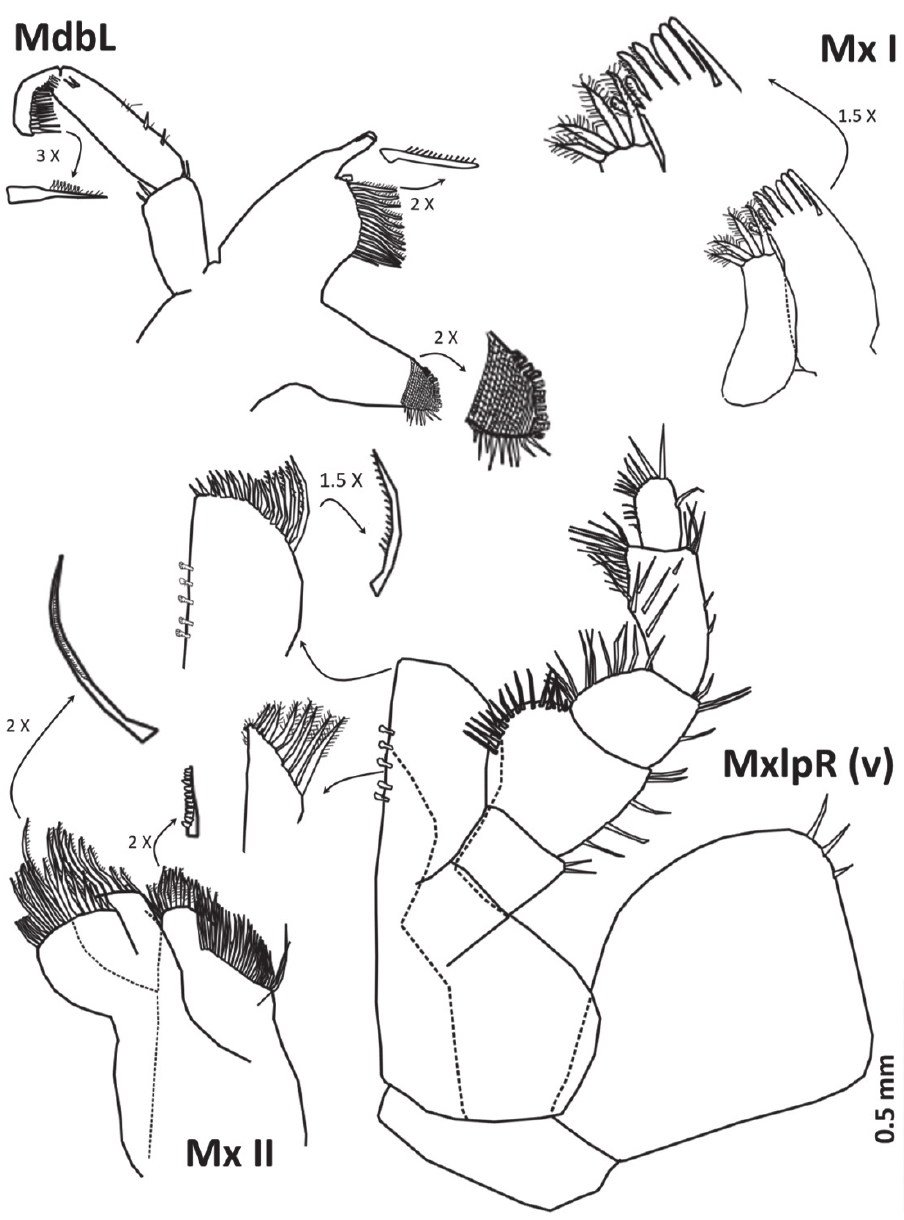
Figure 4. Asellus ismailsezarii sp. nov., Ganow spring, Western Iran. Paratype male, 8.1 mm (TU-SP. 2), mouthparts: MdL, left mandible; Mx I, maxilla I; Mx II, maxilla II, MxlpR (v), right maxilliped with about 10 biserrate setae and parallel row of about 13 long simple setae along in- ner margin. Maxilliped (Fig. 4MxlpR) endite distal margin with about 11 biserrate robust setae, subapically with several rows of short simple setae. Mesial margin curved dorsally, with row of about 8 long biserrate setae, distomesial margin with setulose